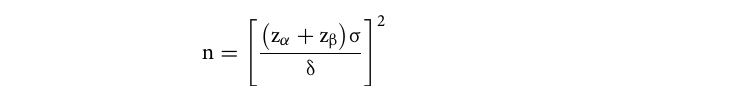
Figure 1. ( a ) Experimental set up for transfemoral residual limb 3D scanning; ( b ) residual limb 3D scan (in red a schematic representation of the two perpendicular lines projected by the laser level on the anterior part of the residual limb); ( c ) the pre-align option of the Surface Best-Fit alignment method: fixed model in blue and mobile model in green; ( d ) alignment result; ( e ) scan cutting plane in orange; ( f ) final mesh. These images were created using VXelements 6.0 (www. creaf orm3d. com) and SOLIDWORKS 2020 software (www. solid world.